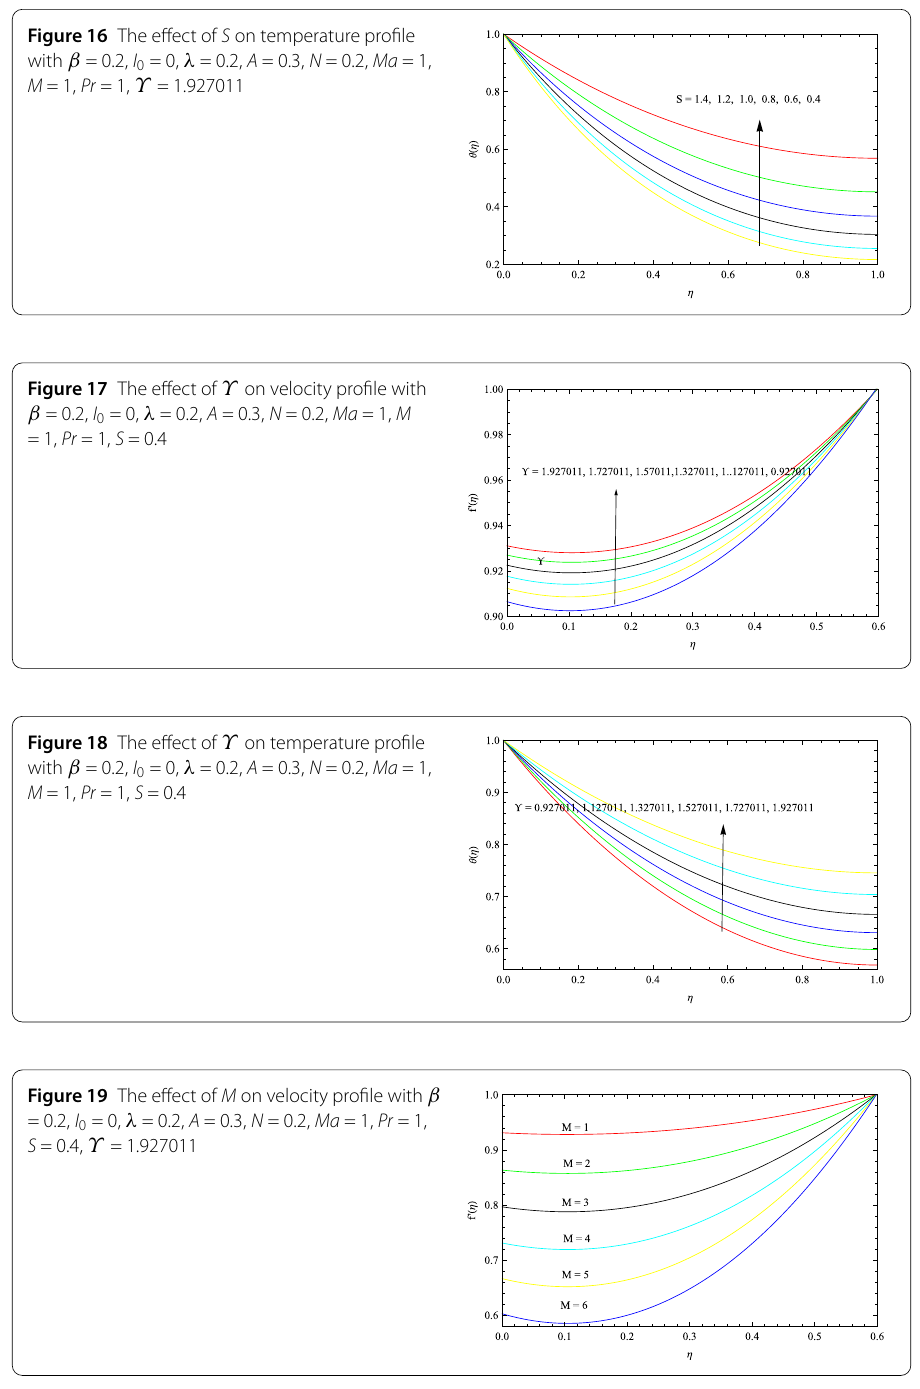
Figure 16 The effect of S on temperature profile with β = 0.2, I 0 = 0, λ = 0.2, A = 0.3, N = 0.2, Ma = 1, M = 1, Pr = 1, Υ = 1.927011